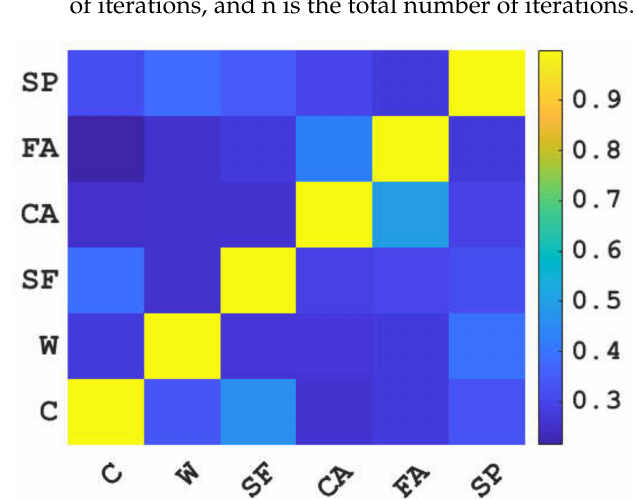
Figure 2. Correlation analysis results of input